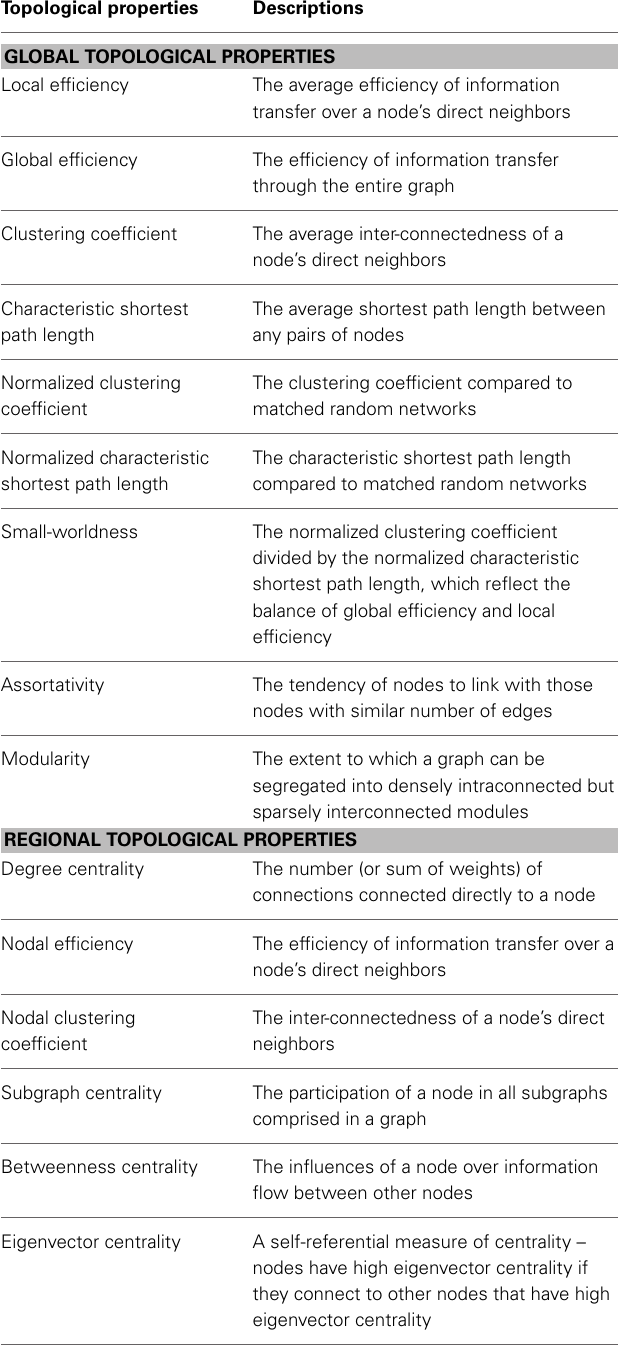
Table 1 | Topological properties of brain graphs examined in the current